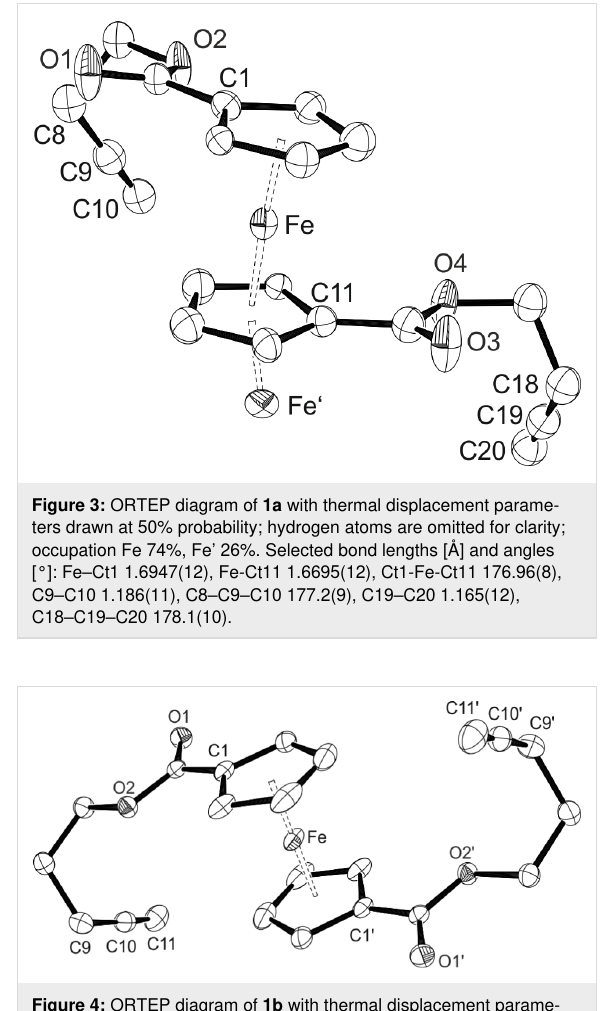
Figure 4: ORTEP diagram of 1b with thermal displacement parame- ters drawn at 50% probability; hydrogen atoms are omitted for clarity. Selected bond lengths [Å] and angles [°]: Fe–Ct 1.6523(7), Ct–Fe–Ct‘ 180.0, C10–C11 1.127(2), C9–C10–C11